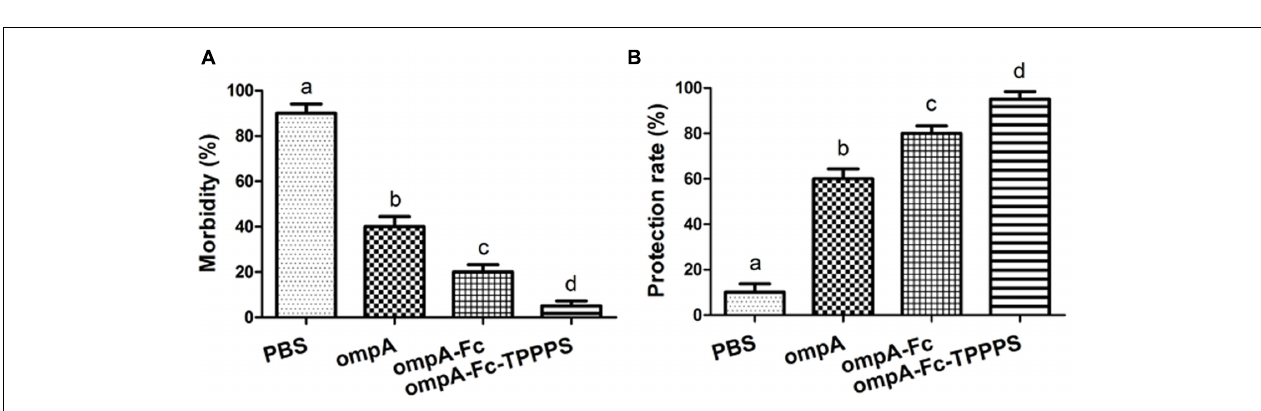
FIGURE 6 | Protective rates of Bordetella avium -challenged chickens. Chickens in four groups were inoculated with ompA subunit vaccine, ompA–Fc subunit vaccine, TPPPS adjuvant ompA–Fc vaccine, and PBS at 1, 7, and 14 dpv. One week after the third vaccination, 20 chickens from each group were challenged intranasally with 10 LD 50 of B. avium LL strain. Morbidity (A) and protective rate (B) were monitored for seven successive days after challenge. Morbidity (%) = No. of chickens with clinical symptoms/Total No. × 100. (B) Protective rate (%) = No. of chickens without clinical symptoms/Total No. × 100. Values shown represent the means ± SD for three independent experiments. Different lowercase letters above the columns indicate significant differences between the different groups ( P ≤